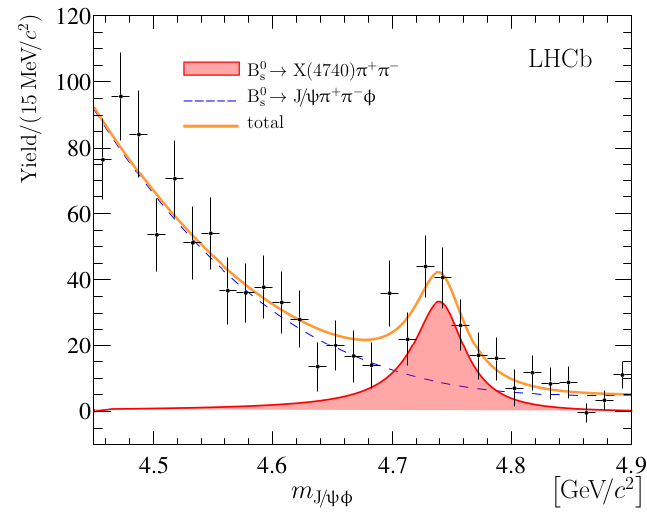
Figure 6: The J /ψφ mass spectrum is shown, where the red shaded area shows the contribution of the X(4740) state, the blue dashed line represents the background, and the orange solid line shows the total